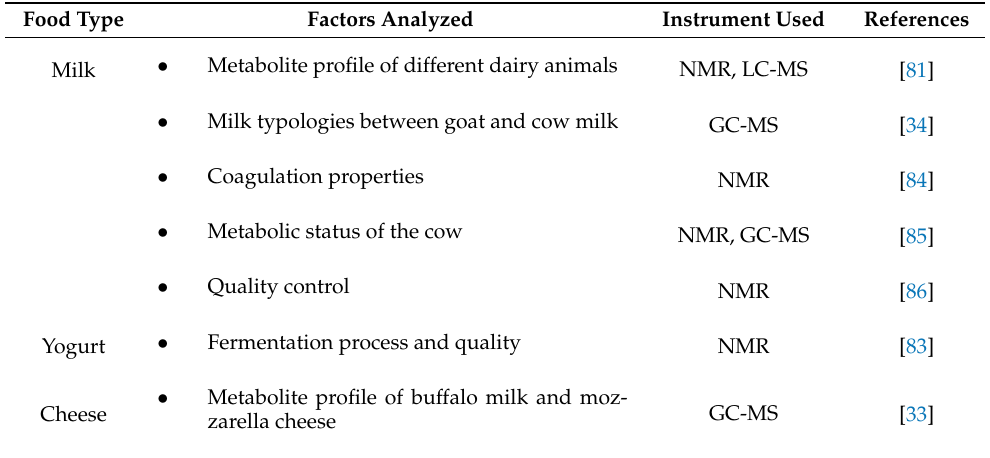
Table 5. Metabolomics approach performed on milk and dairy